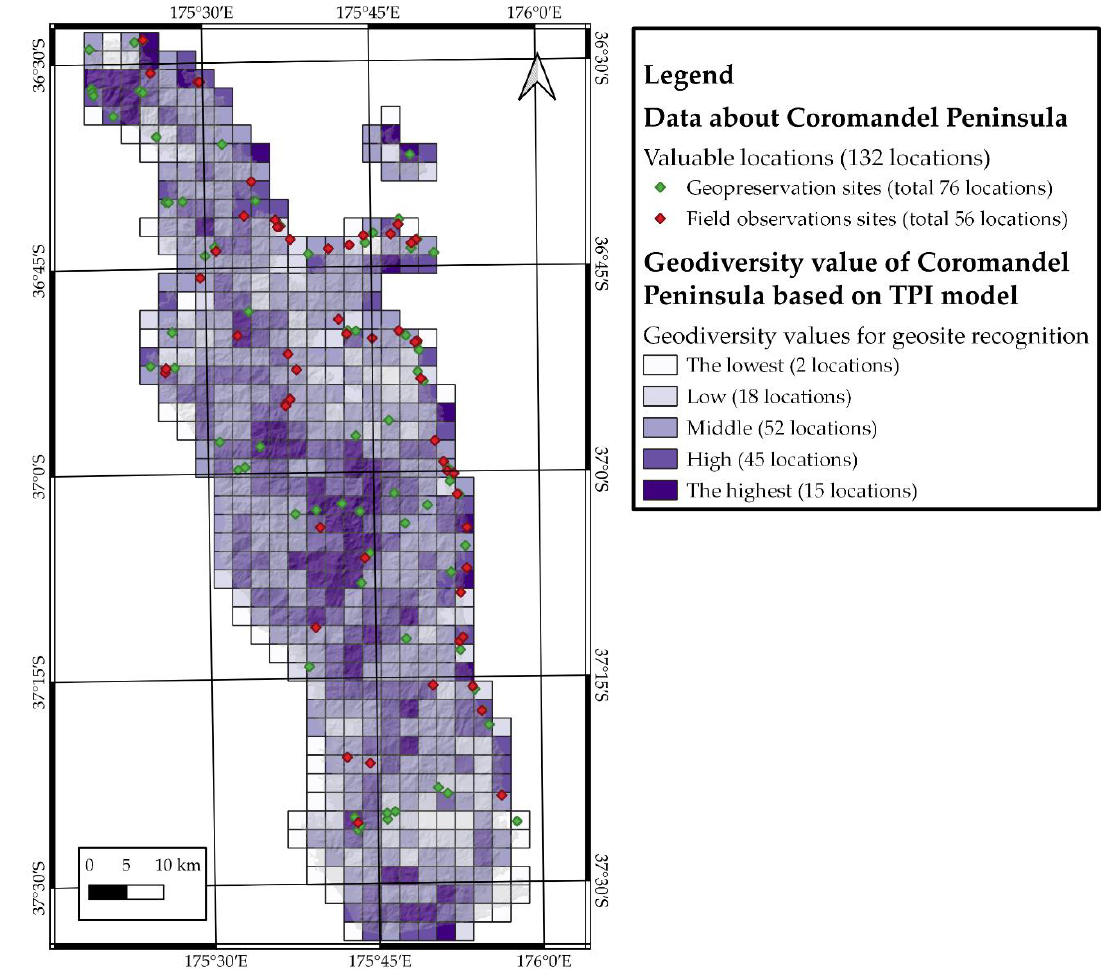
Figure 7. Geodiversity values of Coromandel Peninsula based on TPI model evaluated with natural breaks (Jenks) mode. Valuable locations throughout Coromandel Peninsula gathered through field observation and New Zealand Geopreservation Inventory (http://www.geomarine.org.nz/NZGI/,